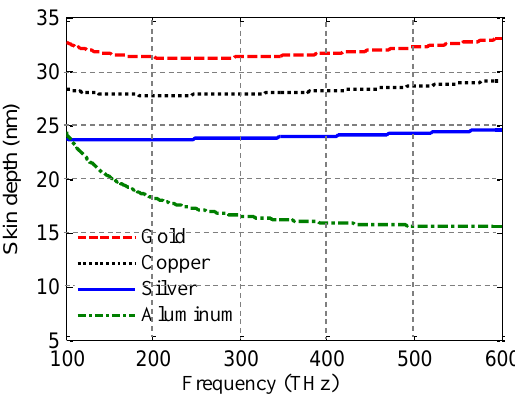
Figure 2 The skin depth variation versus frequency for silver, gold, copper and aluminum metals.